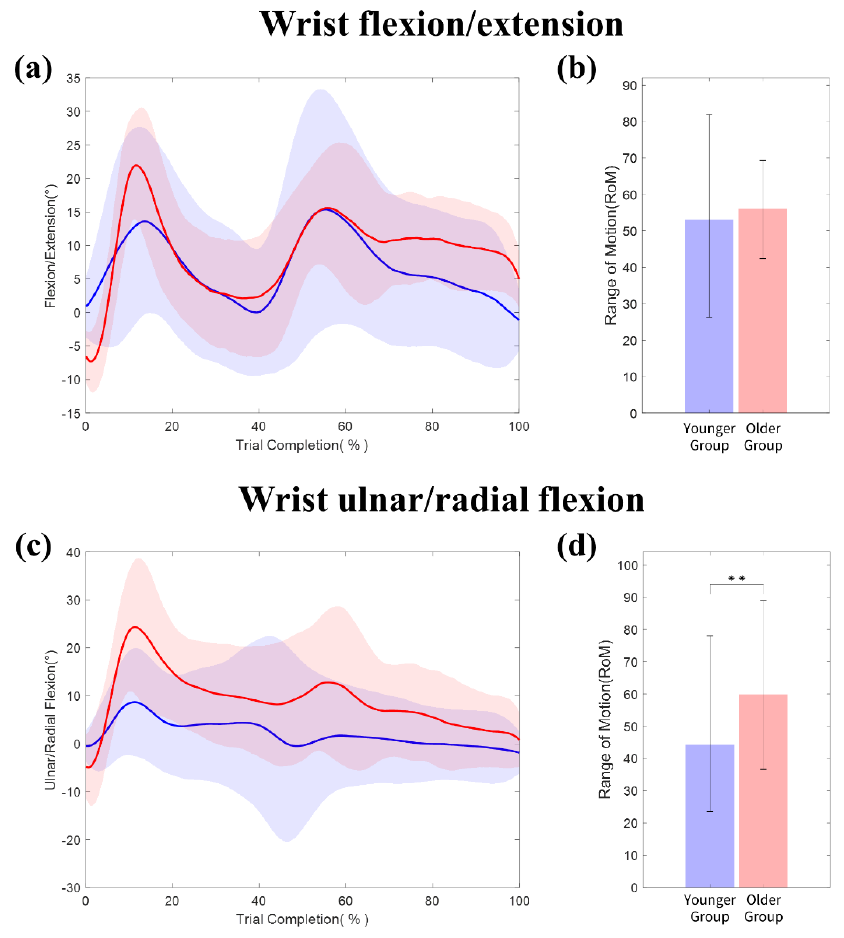
Figure 8. Kinematic trajectories and RoM of the wrist for the young (blue) and older adults (red): ( a ) ( a ) wrist flexion / extension trajectories by age ( b ) wrist flexion / extension by age and ( c ) wrist ulnar / radial wrist flexion/extension trajectories by age ( b ) wrist flexion/extension by age and ( c ) wrist ulnar/radial flexion trajectories by age; ( d ) wrist ulnar / radial flexion RoM by flexion trajectories by age; ( d ) wrist ulnar/radial flexion RoM by age. Wrist movements : The kinematic trajectories of the wrist flexion/extension and radial/ulnar